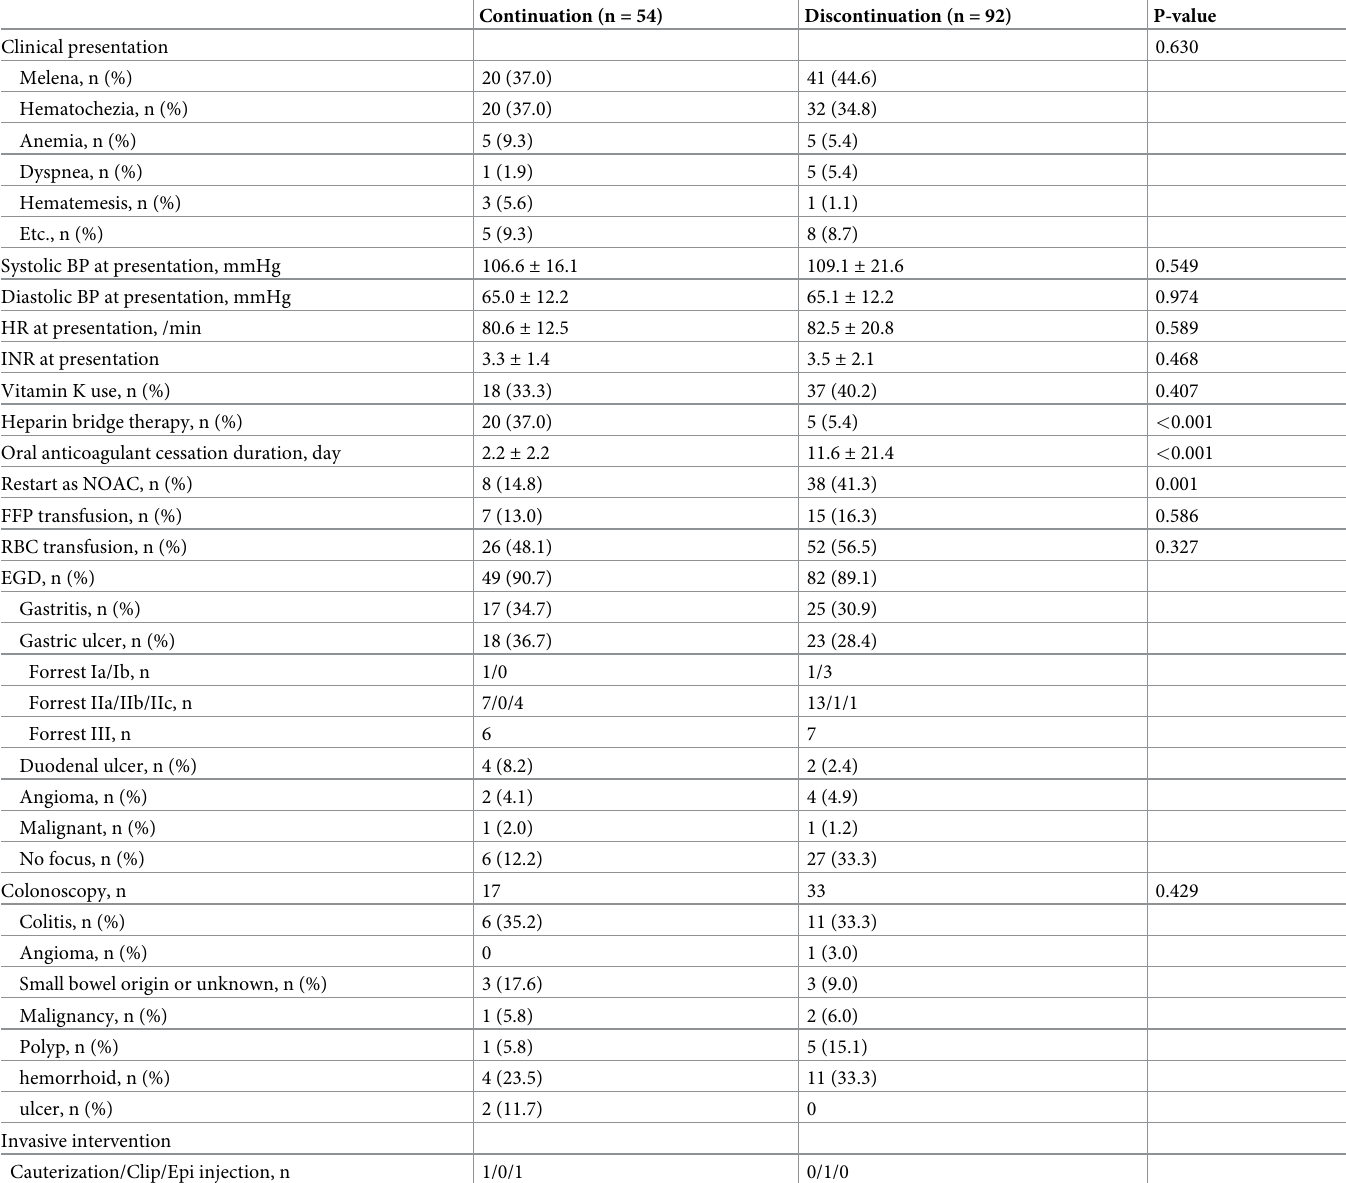
Table 2. Characteristics of patients at presentation, treatment strategies and clinical and endoscopic bleeding